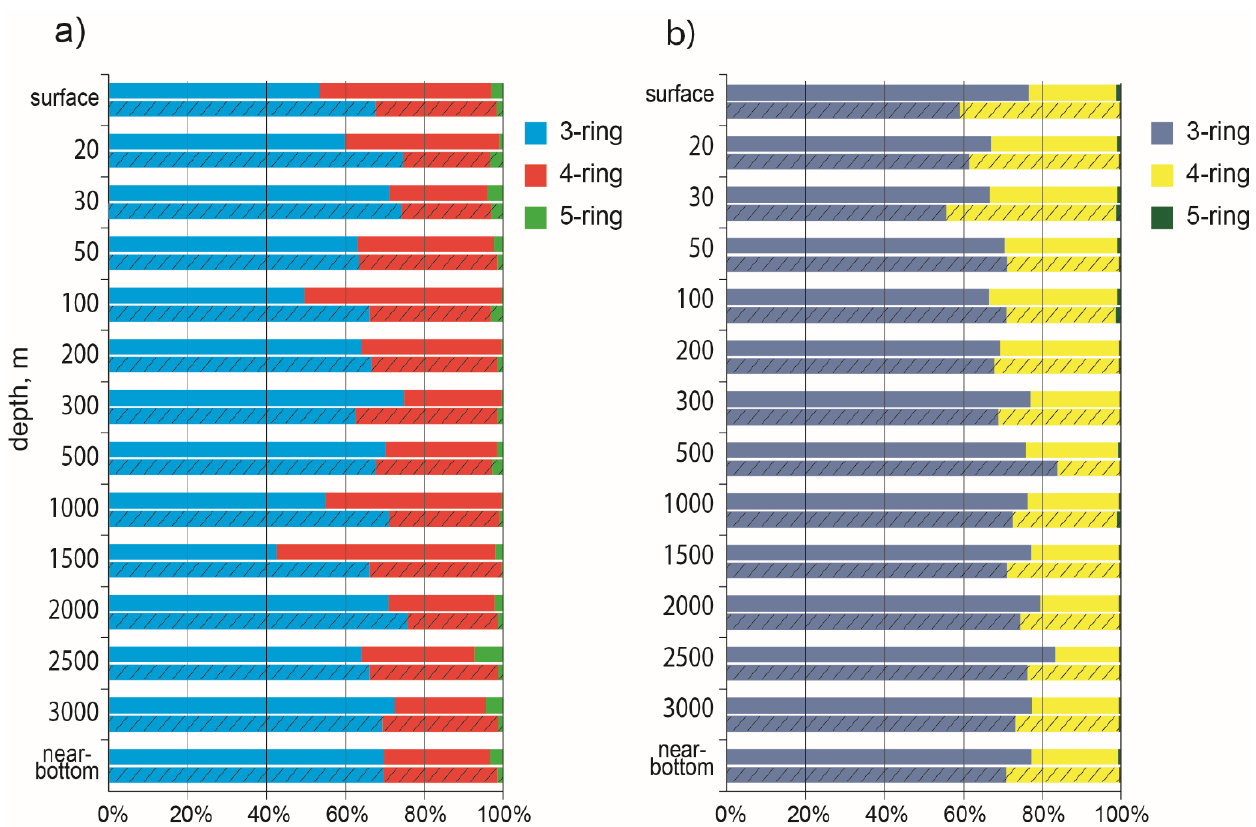
Figure 6. The compositional profiles of ( a ) PPAHs and ( b ) DPAHs in the Japan Basin. Empty columns denote PAH composition at St.21; columns with strokes denote PAH composition at St.29.